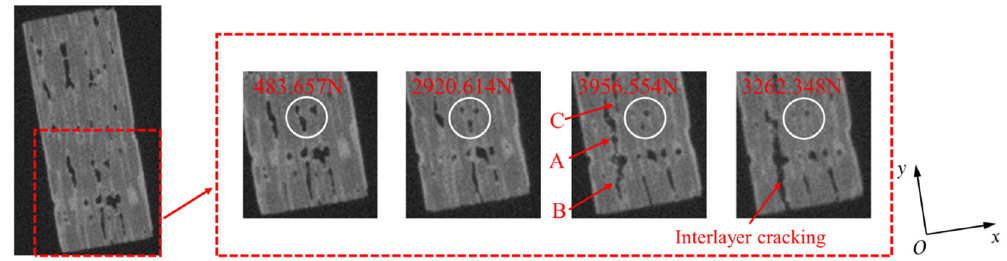
Figure 8: Damage evolution process of local area on YOX section.